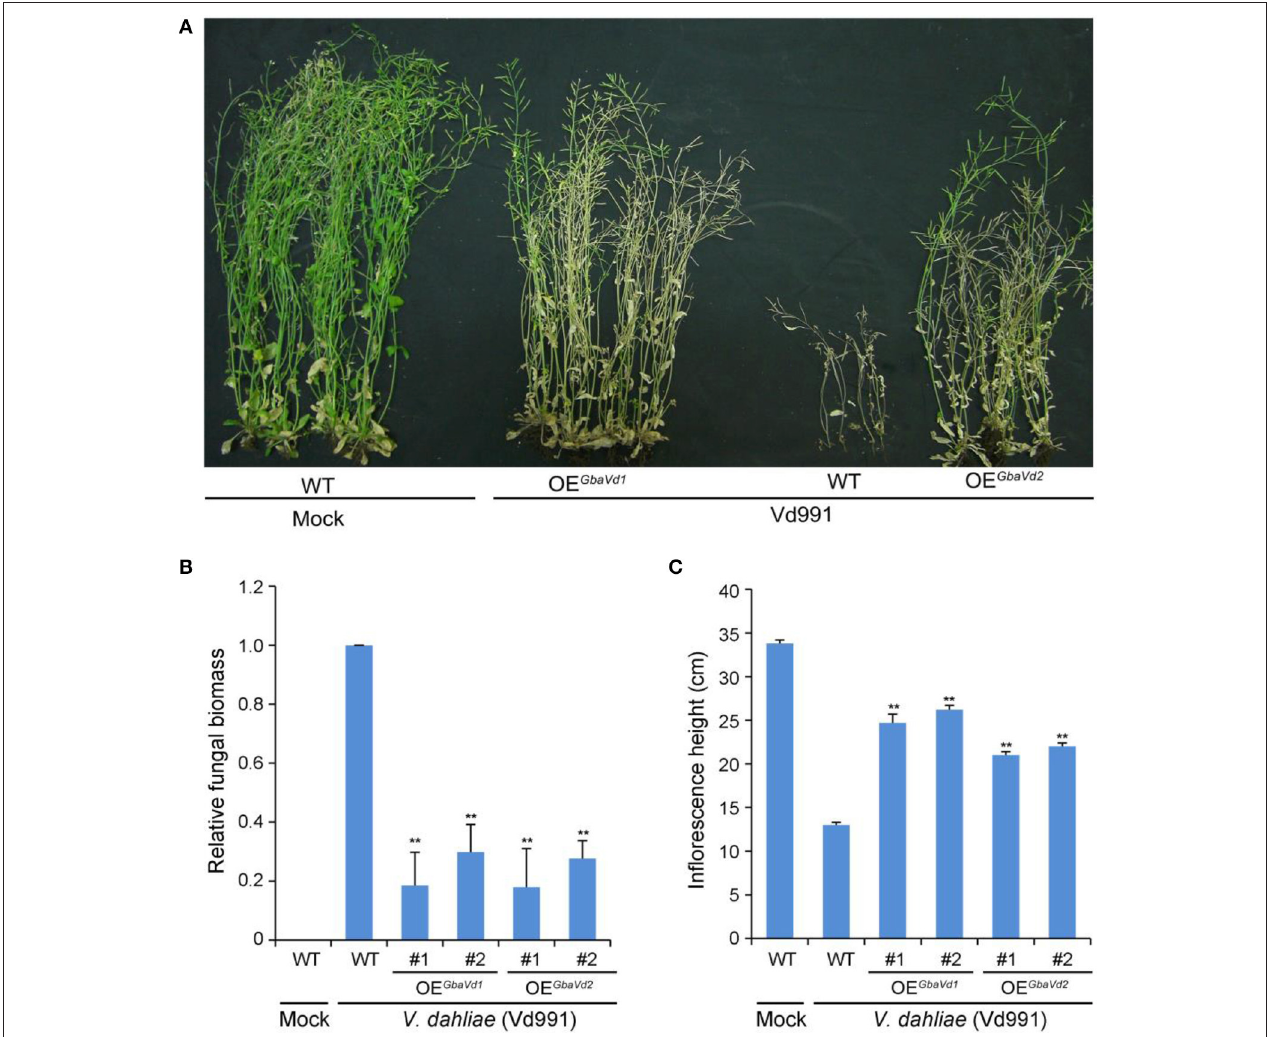
FIGURE 4 | GbaVd1 and GbaVd2 conferred Verticillium wilt resistance in transgenic Arabidopsis . (A) Identification of Verticillium wilt resistance after interfamily transfer of GbaVd1 and GbaVd2 in Arabidopsis . Four-week-old seedlings of homozygote transgenic Arabidopsis (T 3 ) were inoculated with 5 mL of conidial suspension (5 × 10 6 conidia/mL). The Verticillium wilt phenotypes were determined and photographed 4weeks after inoculation. WT, the wild-type Col-0 ; Mock, inoculation with sterile water; OE GbaVd1 /OE GbaVd2 , transgenic plants overexpressing GbaVd1 or GbaVd2 , respectively. (B) Real-time PCR quantification of fungal biomass in GbaVd1 or GbaVd2 transgenic plants. Error bars represent standard errors, **significant differences ( P ≤ 0.01), according to unpaired Student’s t -test. (C) Investigation of the inflorescence height after inoculation with V. dahliae . Error bars represent standard errors, **significant differences ( P ≤ 0.01), according to unpaired Student’s t